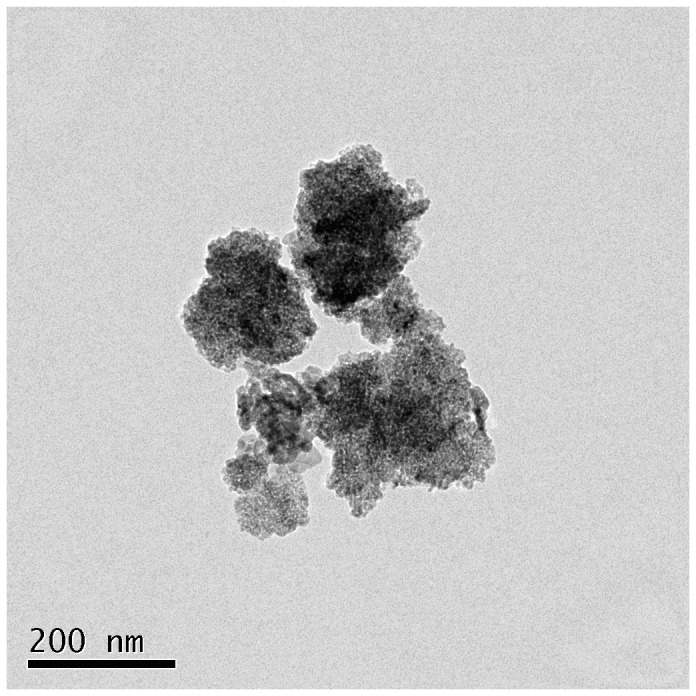
Transmission electron microscope (TEM) image of anatase TiO2 NPs.